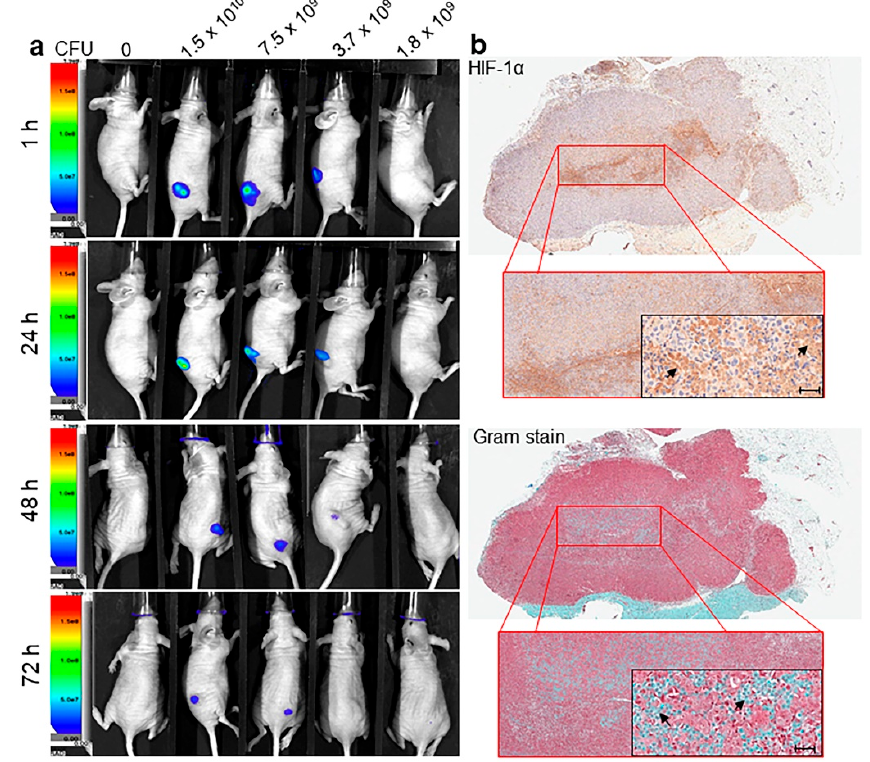
Figure 4. Detection of L. lactis -IRFP713 via advance molecular imaging and co-localization of L. lactis with HIF-1 α in the core of the melanoma tumor. ( a ) Representative time-course imaging of tumor bearing mice administered with IRFP713-expressing L. lactis . BALB / c mice were administered 1 × 10 6 A375 cells in the right flank by s.c. injection. Ten days after tumor inoculation, mice were administered IRFP713-expressing L. lactis at increasing concentrations (0, 1.8 × 10 9 , 3.7 × 10 9 , 7.5 × 10 9 and 1.5 × 10 10 CFU) by i.t. injection. Whole body imaging was performed at 1, 24, 48 and 72 h with the AMI-1000-X instrument under 690 / 713 nanometers (nm) excitation and emission visualization, respectively; ( b ) Representative IHC staining of HIF-1 α and Gram staining of A375 tumor sections from BALB / c mice injected i.t. with L. lactis -IRFP713 at a magnification of × 100 and × 400. Arrows indicate gram-positive bacteria cells and cells positive for HIF-1 α , respectively. Whole tissue slides were scanned with Leica Aperio ImageScope with 40× magnification. Scale bar = 50 µm.